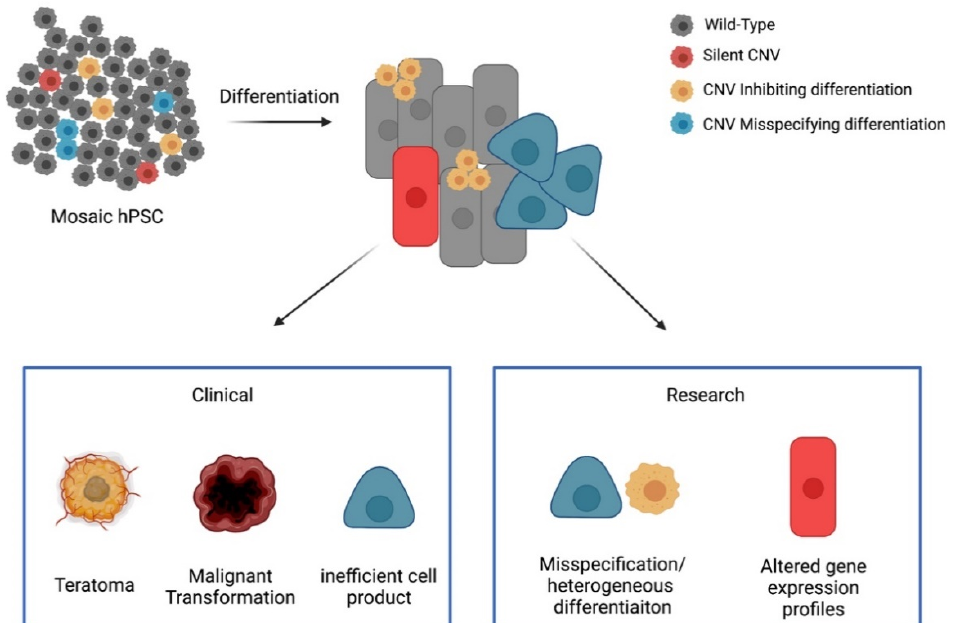
Figure 1. Overview of the potential impacts of chromosomal abnormalities on research and clinical outcomes: Any given population of hPSCs may be present as a mosaic (multicolored starting undifferentiated population). Once differentiated, each of these cells has the potential to negatively influence the differentiation outcome (heterogeneity or gene expression profiles) or be the source of a future negative outcome (teratoma or malignant transformation) (Created with BioRender.com accessed on 3 November 2021).